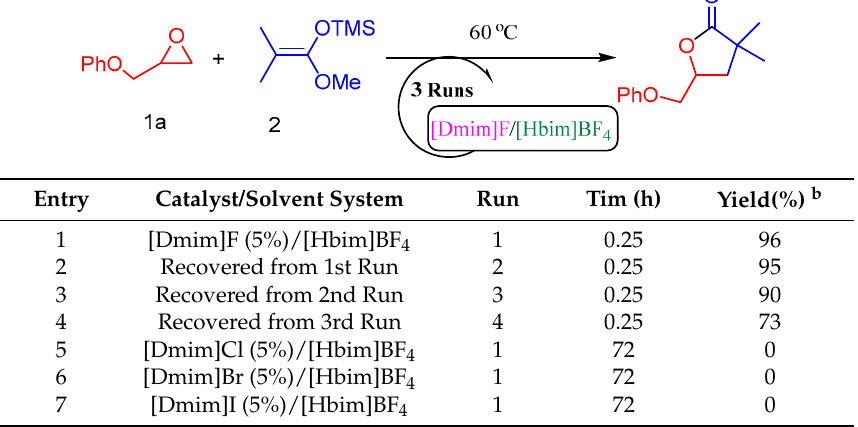
Table 2. Recycling study of ionic liquids mixture and efficiency of 1,3-dimethylimidazolium fluoride in comparison with other 1,3-dimethylimidazolium halides a .